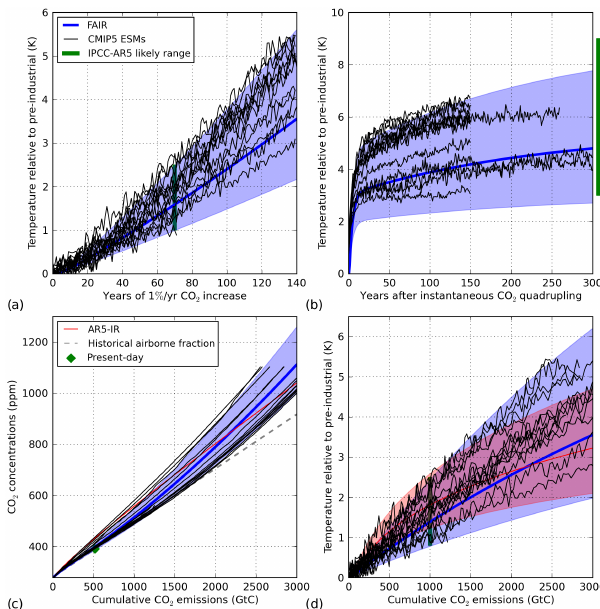
Figure 7. Climate response uncertainties in the FAIR (blue), AR5- IR (red), and CMIP5 (black) models. (a) shows the temperature responses to a 1%year − 1 concentration increase scenario. The green bar indicates the IPCC AR5 TCR likely range. The blue shading in (a and b) shows the response of FAIR under IPCC AR5 upper and lower likely TCR and ECS ranges. (b) shows the responses to an instantaneous quadrupling of atmospheric CO 2 , which is held fixed subsequently. The green bar indicates the as- sessed equilibrium warming compatible with the IPCC AR5 ECS likely range. (c) shows concentrations as a function of cumulative emissions in the 1%year − 1 scenario. The plumes in (c and d) show the FAIR simulated response under the IPCC AR5 likely TCR and ECS ranges, with an additional ± 13% perturbation to the r 0 , r T , and r C parameters for the high/low end response. The dashed grey line indicates a constant cumulative airborne fraction that is con- sistent with the present-day state of the climate system (green dia- mond). (d) shows warming as a function of cumulative emissions in the 1%year − 1 scenario. The green bar shows the IPCC AR5 likely 0.8–2.5KTtC − 1 assessed range for transient climate response to cumulative emissions